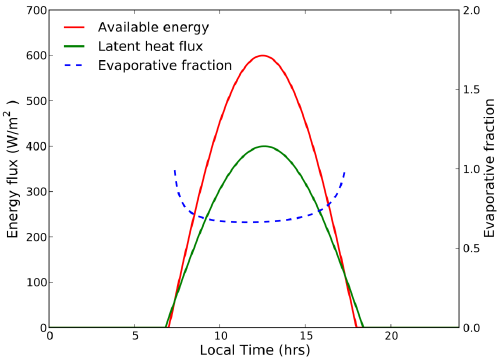
Fig. 1. Conceptual framework for the diurnal variations of surface Figure 1. Conceptual framework for the diurnal variations of surface energy components and EF. The energy components and EF. The solid red line represents surface solid red line represents surface available energy, the solid green line represents latent heat flux, and the available energy, the solid green line represents latent heat flux, and the dashed blue line represents EF. dashed blue line represents EF.